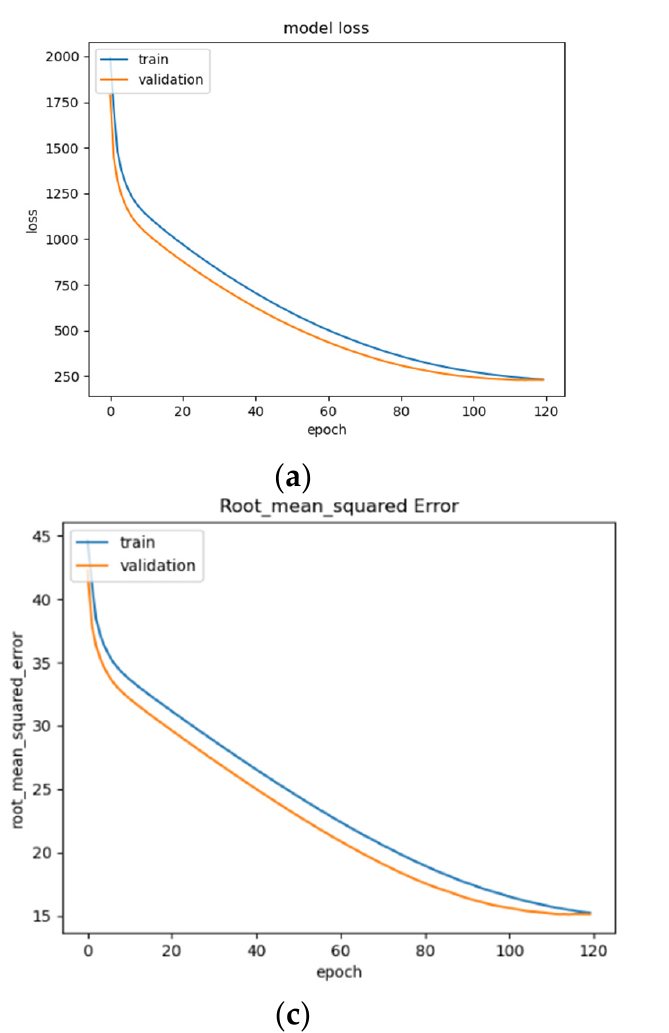
Figure 14. LSTM model performance: ( a ) Loss (MSE) of LSTM trained on EEG data with regression analysis; ( b ) MAE of LSTM trained on raw EEG data with regression analysis; ( c ) RMSE of LSTM trained on raw EEG data with regression analysis.